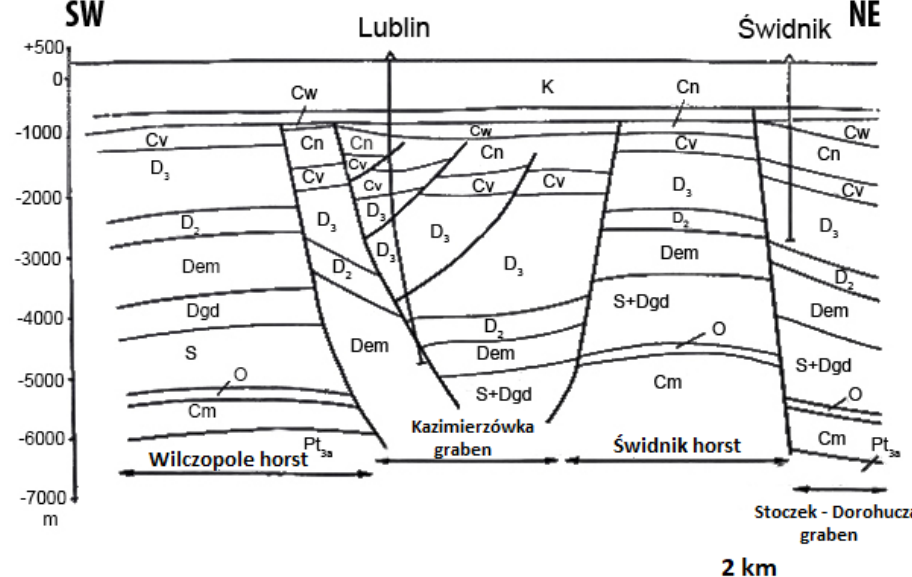
Figure 2. Geological cross-section (BB’ on Figure 3) of the Kazimierz ó wka graben [19]; Pt 3a —Upper Proterozoic (crystalline rocks); Cm—Cambrian; O—Ordovician; S—Silurian; Dgd—Lower Devonian, marine facies of Gedinnian and Siegenian; Dem—Lower Devonian, old red facies of Emsian; D 2 —Middle Devonian; D 3 —Upper Devonian; Cv—Carboniferous-Visean; Cn—Carboniferous-Namurian; Cw—Carboniferous-Westphalian; K—Cretaceous.